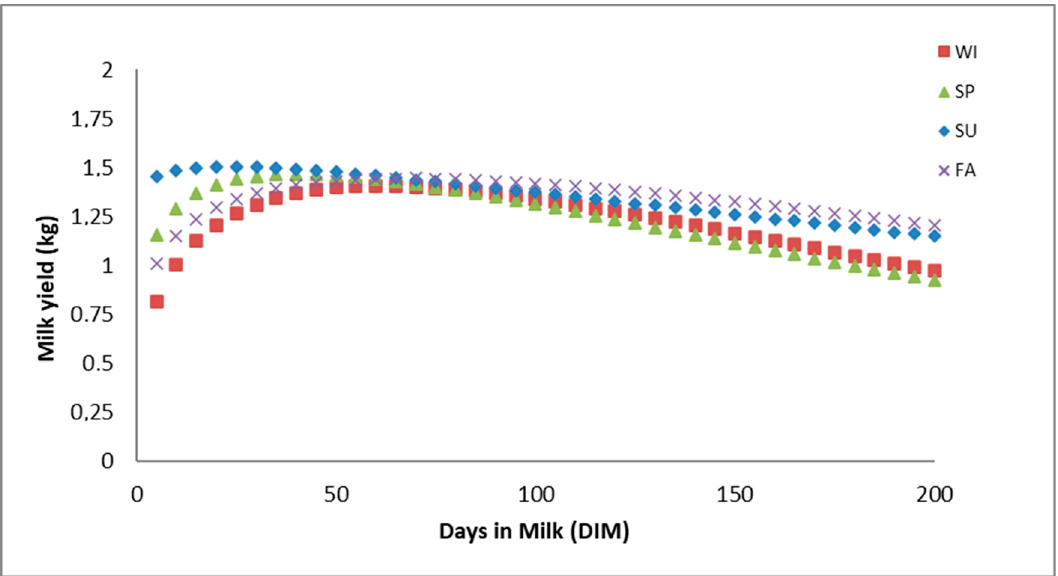
Figure 4. Linearized Wood’s function lactation curves across kidding season levels (WI: winter, SP: spring; SU: summer; FA: autumn/fall).